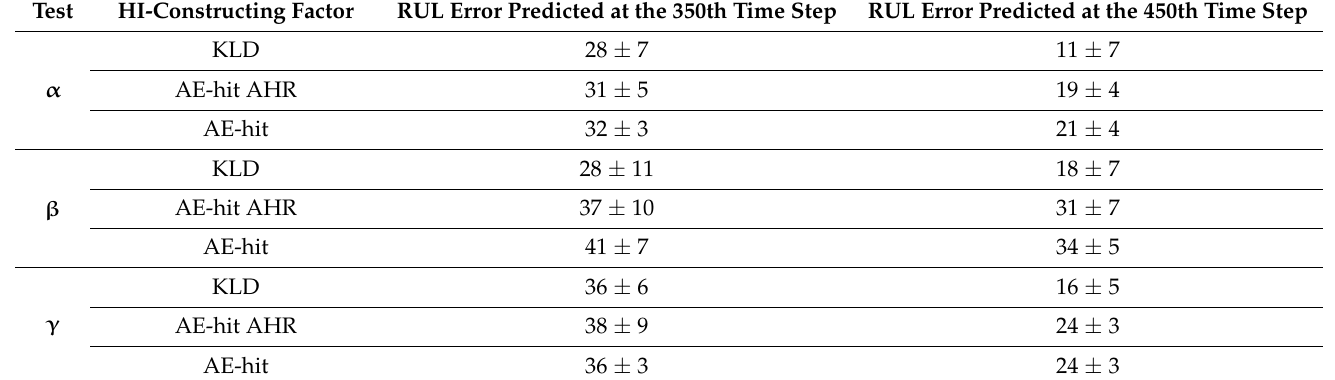
Table 2. RUL prognosis performance assessment of the proposed HI with AE-hit and AE-hit AHR